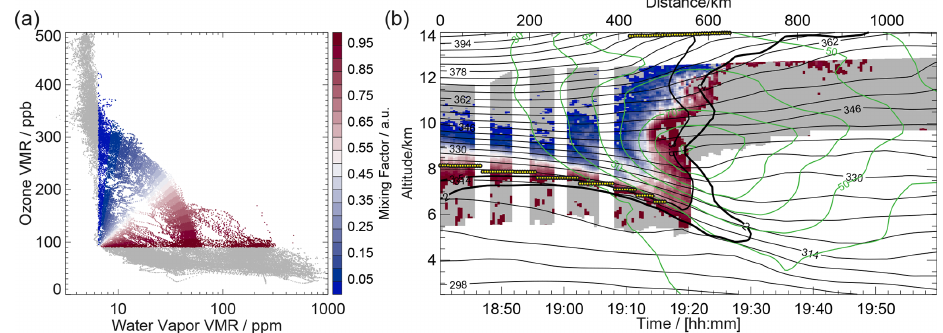
Figure 7. Mixing factor diagnostic for all collocated measurements in (a) T–T space using lower limits for H 2 O VMR of 6.5ppm and for O 3 VMR of 90ppb for selecting mixed air masses (for details see text) and (b) projected back to geometrical